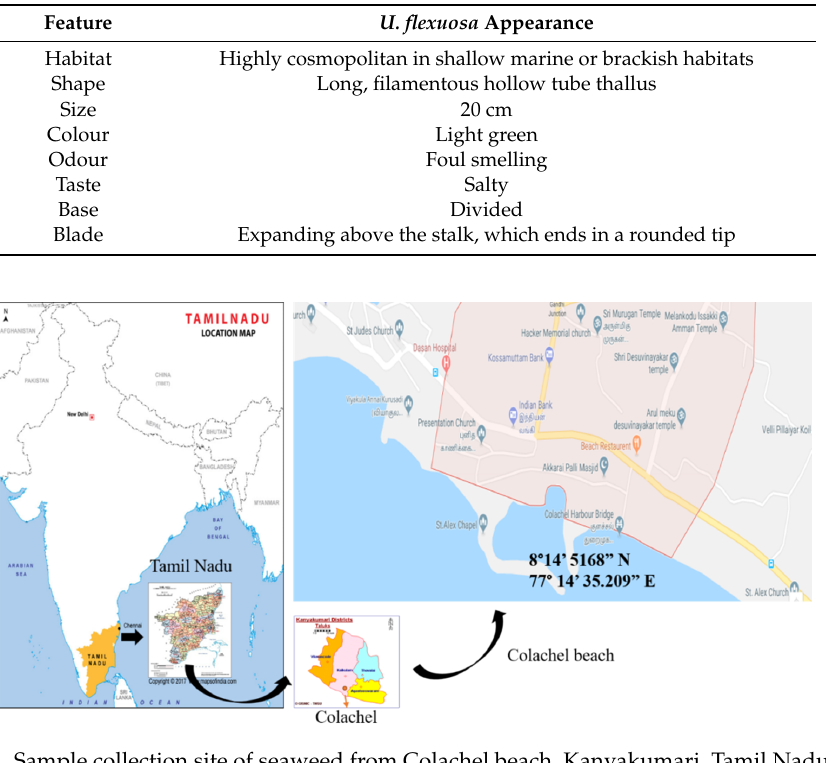
Figure 1. Sample collection site of seaweed from Colachel beach, Kanyakumari, Tamil Nadu, India.